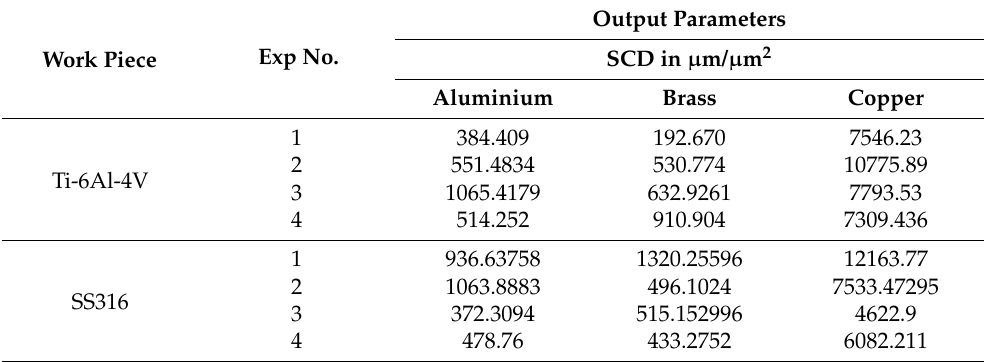
Table 11. The values of SCD for different work pieces with different tool–work piece combinations for different